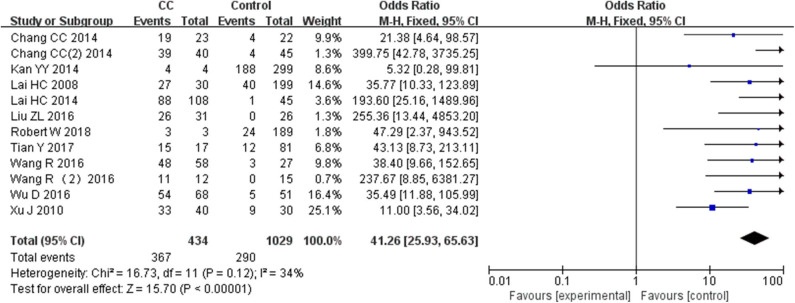
Forest plots for associations of SOX1 promoter hypermethylation with the risk of cervical cancer. The squares represent the ORs for individual studies. The size of the square reflects the weight of included studies. Bars represent the 95% confidence intervals (CIs). The center of the diamond represents the summary effect size.